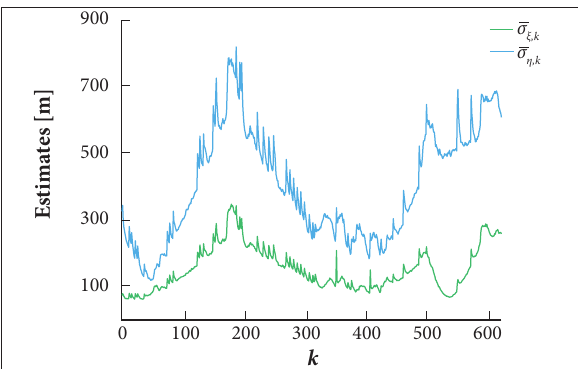
Figure 5. Estimated standard deviation of IMMPDAF errors from